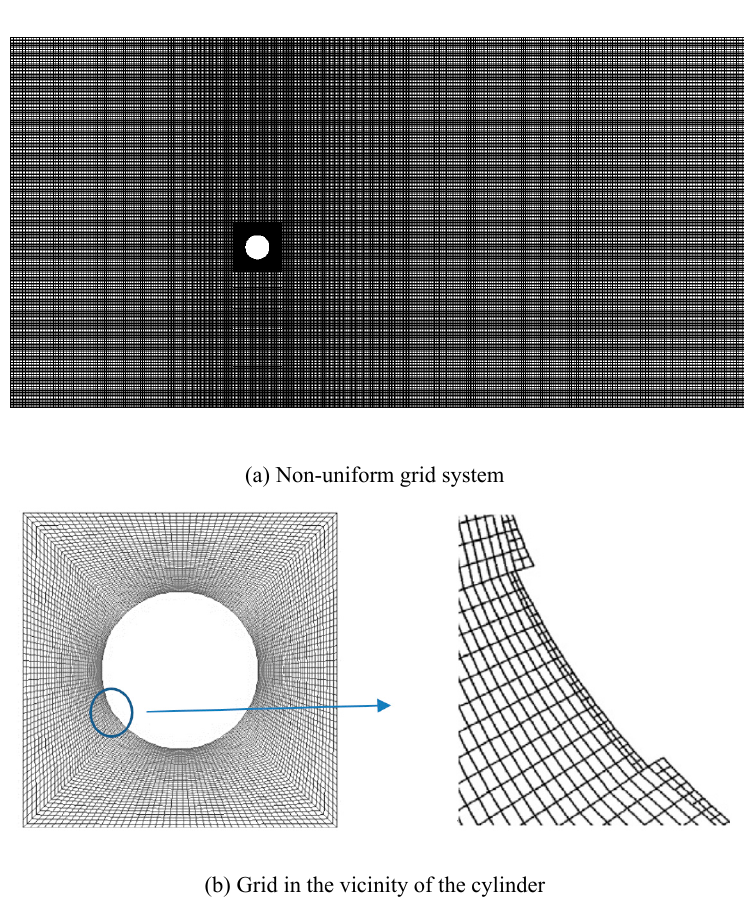
Figure 3. Grid system. Table 1. Grid independent verification ( Re = 35,000).